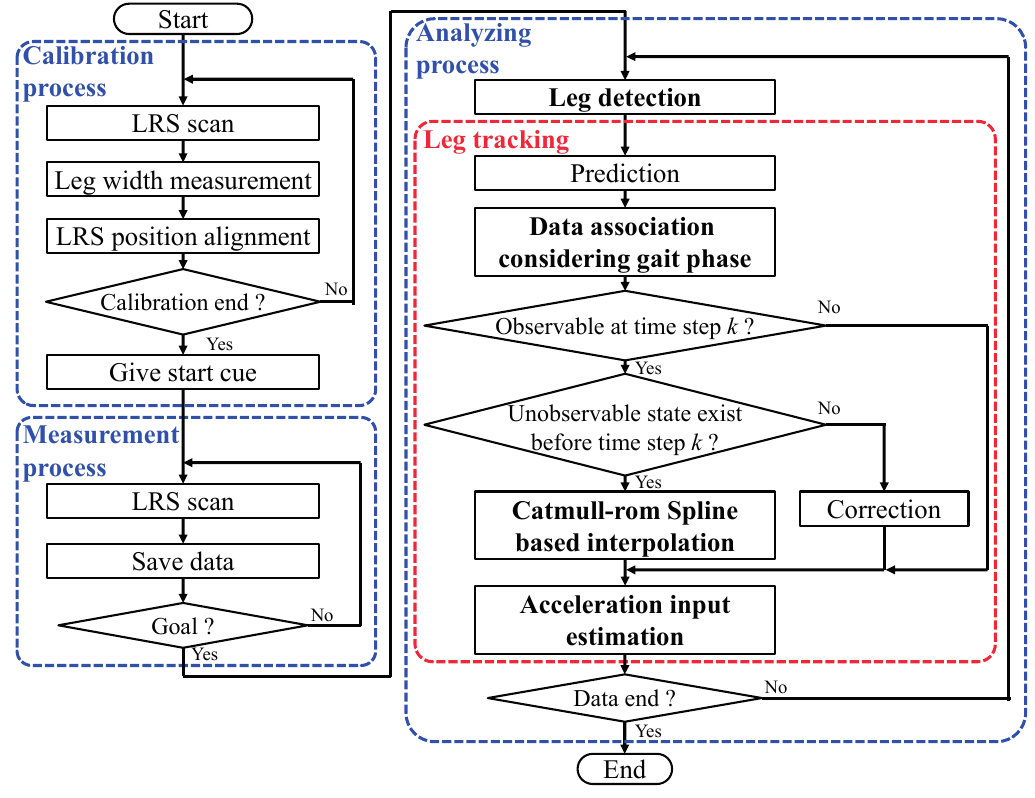
Figure 5. Algorithm of the gait measurement system using a laser range sensor (LRS) for the